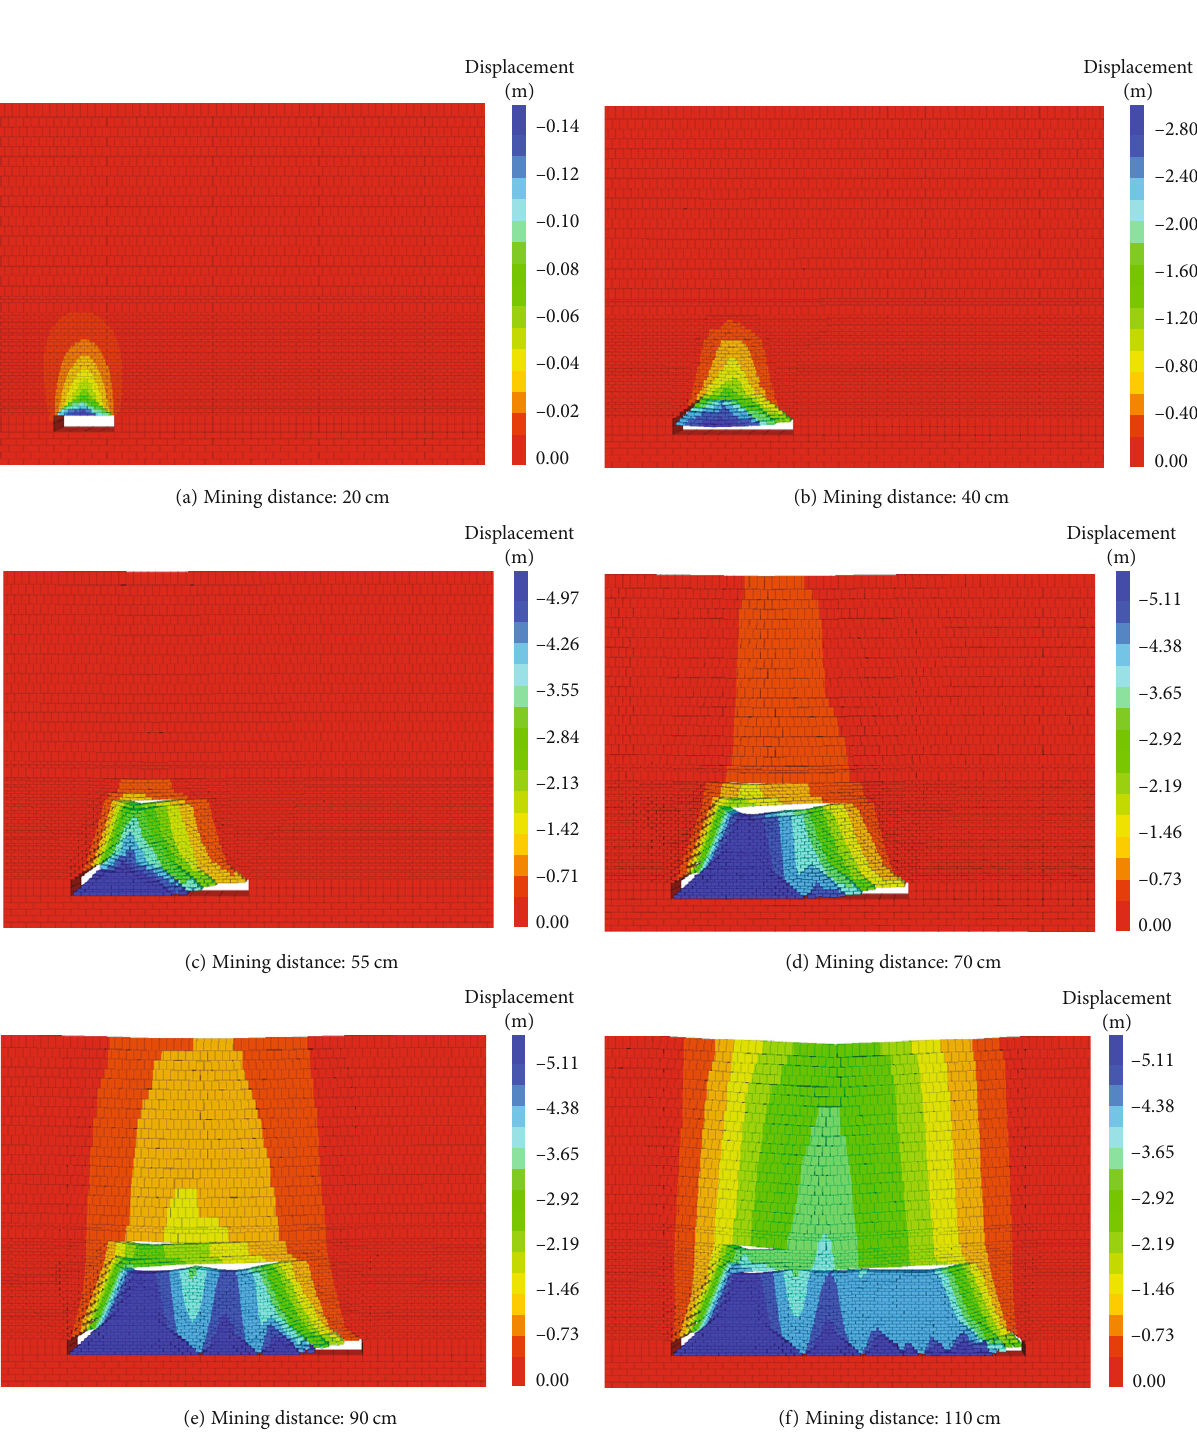
Figure 9: Vertical displacement variation of the roof during the advancement of the mining